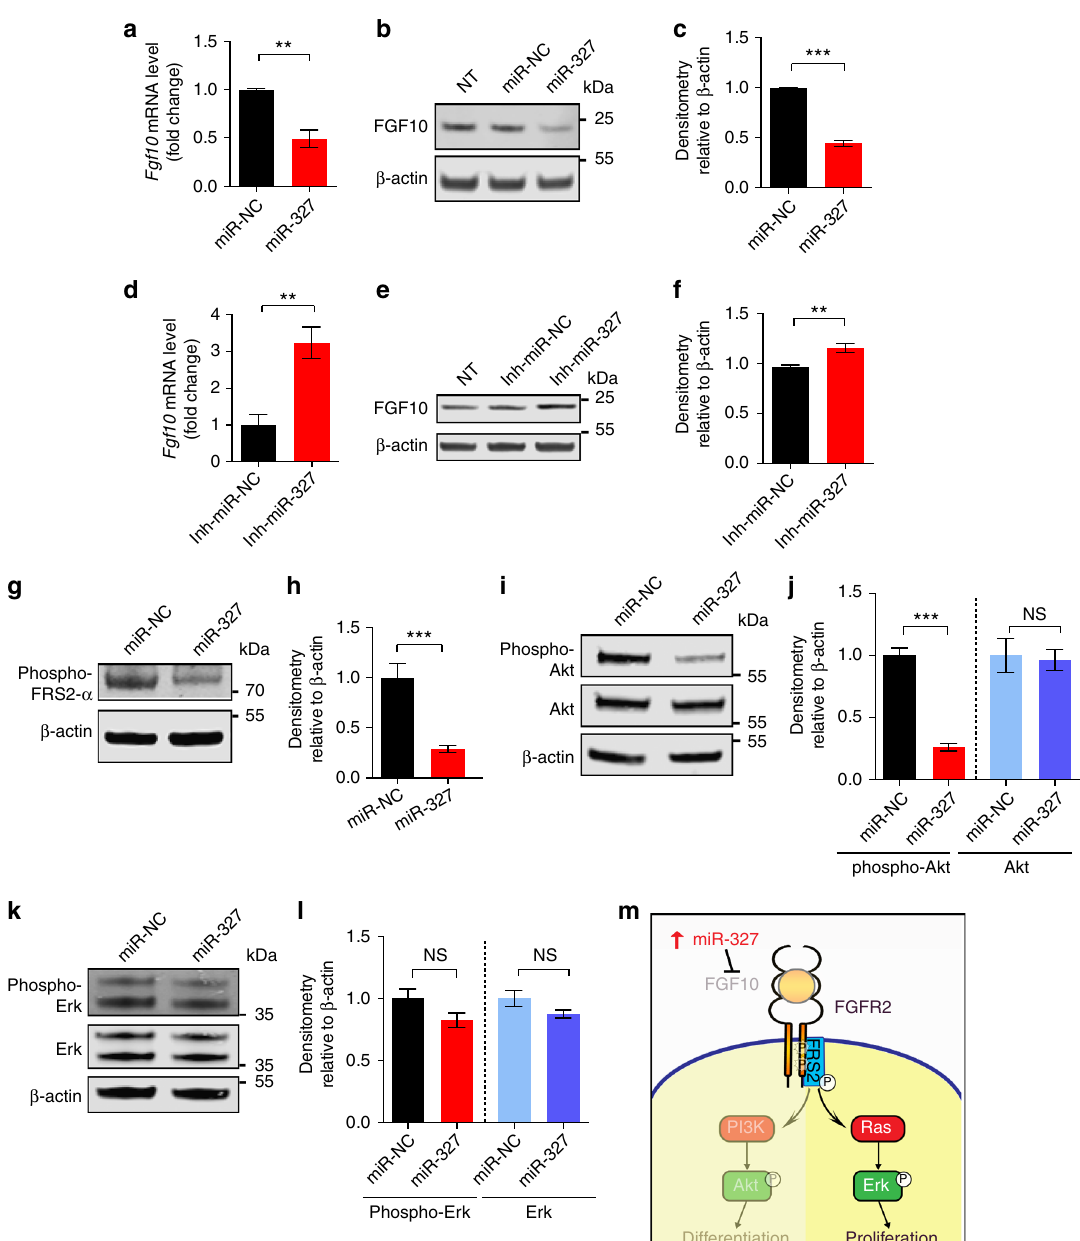
Fig. 4 miR-327 mimics block FGF10 – FGFR2-triggered PI3K – Akt signaling. a qPCR analysis of Fgf10 in miR-negative control (miR-NC) and miR-327 mimic- treated 3T3-L1 preadipocytes ( n = 5 samples per group). b , c Western immunoblot analysis and quanti fi cation of FGF10 in miR-NC and miR-327 mimic- treated 3T3-L1 preadipocytes ( n = 3 samples per group). d qPCR analysis of Fgf10 and e , f Western immunoblot analysis and quanti fi cation of FGF10 in inhibitor miR-negative control (Inh-miR-NC) and miR-327-inhibitor (Inh-miR-327)-treated 3T3-L1 preadipocytes ( n = 5 samples per group). g – l Western immunoblot analysis and quanti fi cation of g , h phospho-FRS2- α , i , j phospho-Akt and Akt and k , l phospho-Erk and Erk in miR-NC and miR-327 mimic- treated 3T3-L1 cells ( n = 3 samples per group). m Schematic diagram of the FGF10 – FGFR2 signaling pathway for cell proliferation and differentiation. The Ras – Erk signaling is crucial for cell proliferation. The PI3K – Akt pathway is essential for cell differentiation. miR-327 speci fi cally blocks the FGF10 – FGFR2 – triggered PI3K – Akt signaling during preadipocyte differentiation.). kDa, kilodalton. NS, not signi fi cant. * P < 0.05, ** P < 0.01, and *** P < 0.001 by Student ’ s t -test. Data presented as mean ± s.e.m.